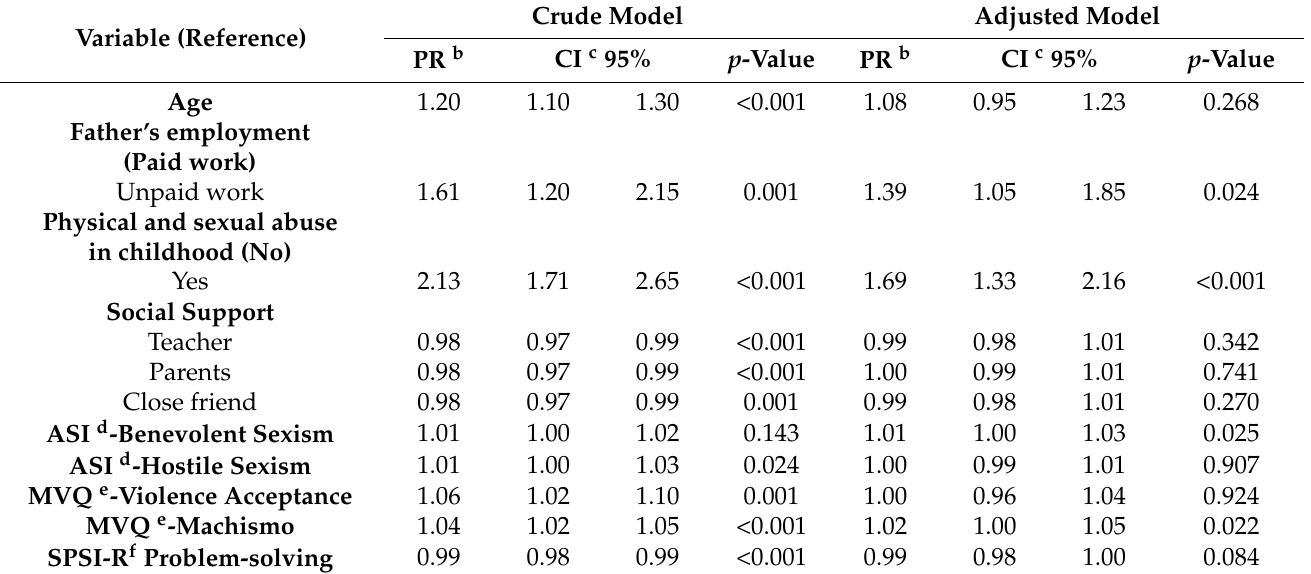
Table 3. Factors Associated with Dating Violence Among Girls Ages 13–16 From Alicante, Spain ( n = 255), Rome, Italy ( n = 285), Iasi, Romania ( n = 343), Matosinhos, Portugal ( n = 259), Poznan, Poland ( n = 190) and Cardiff, UK ( n = 204), 2018–2019 a.